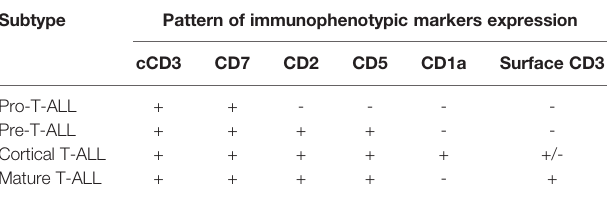
TABLE 1 | EGIL Classi fi cation of T-ALL (8 –